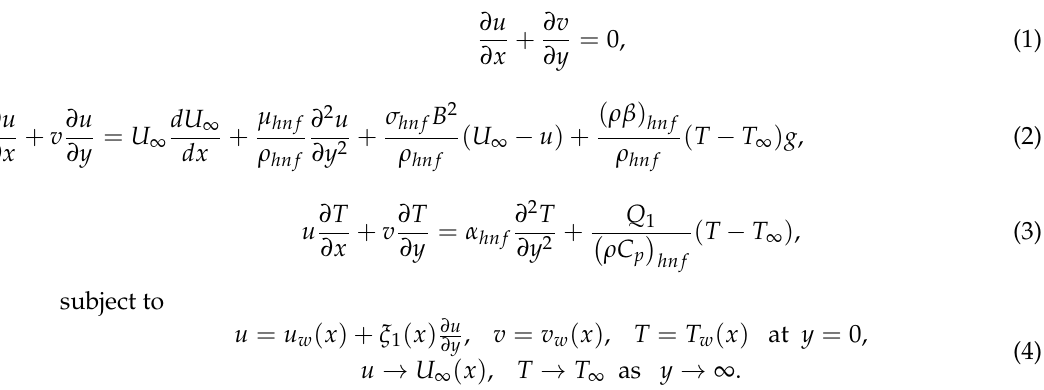
At this point, u represents the velocity component along the x -axis, while v represents the velocity component along the y -axis. The acceleration due to gravity is denoted